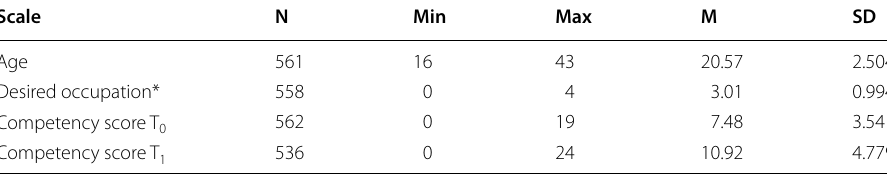
Table 8 Descriptive statistics on further trainee